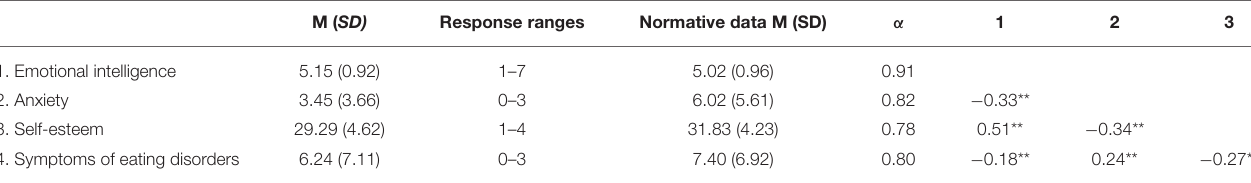
TABLE 2 | Descriptive statistics, response ranges, normative data, reliability, and bivariate correlations.